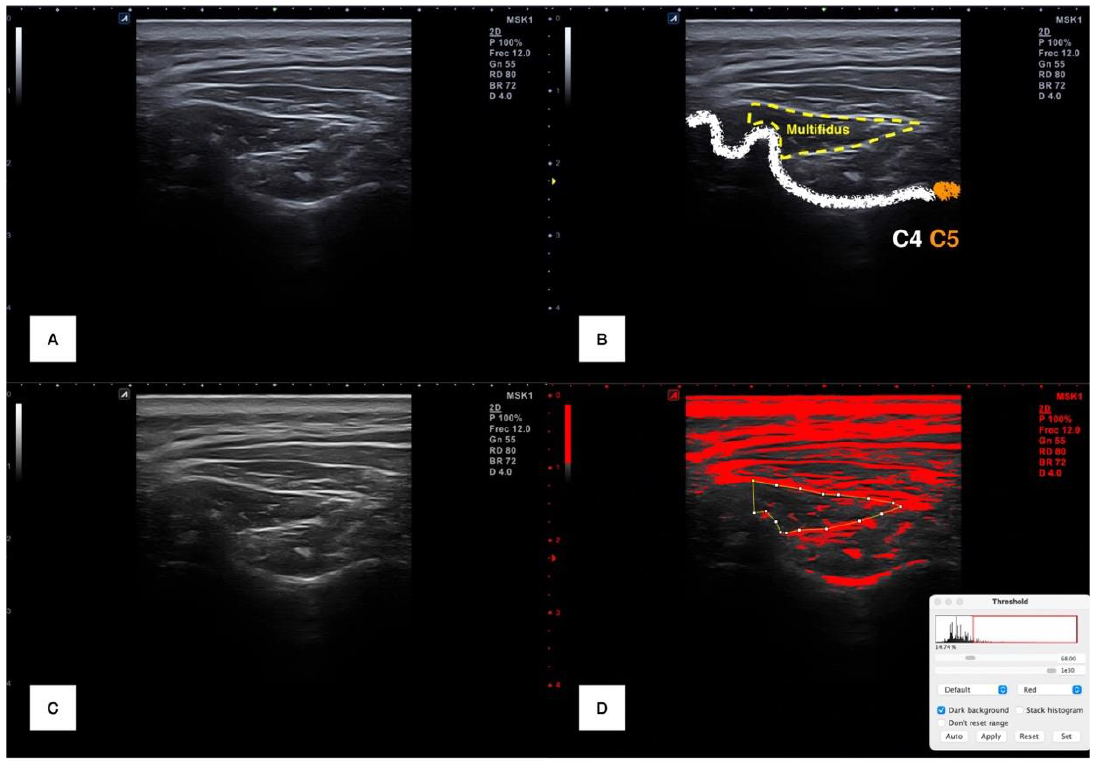
Figure 1. Ultrasound imaging processing. Raw image at C4 – C5 level ( A ); raw image with cervical multifidus muscle delimitation ( B ); 36-bits image transformation ( C ) and selection of range of pixels for isolating the intramuscular infiltration (marked in red) ( D ).